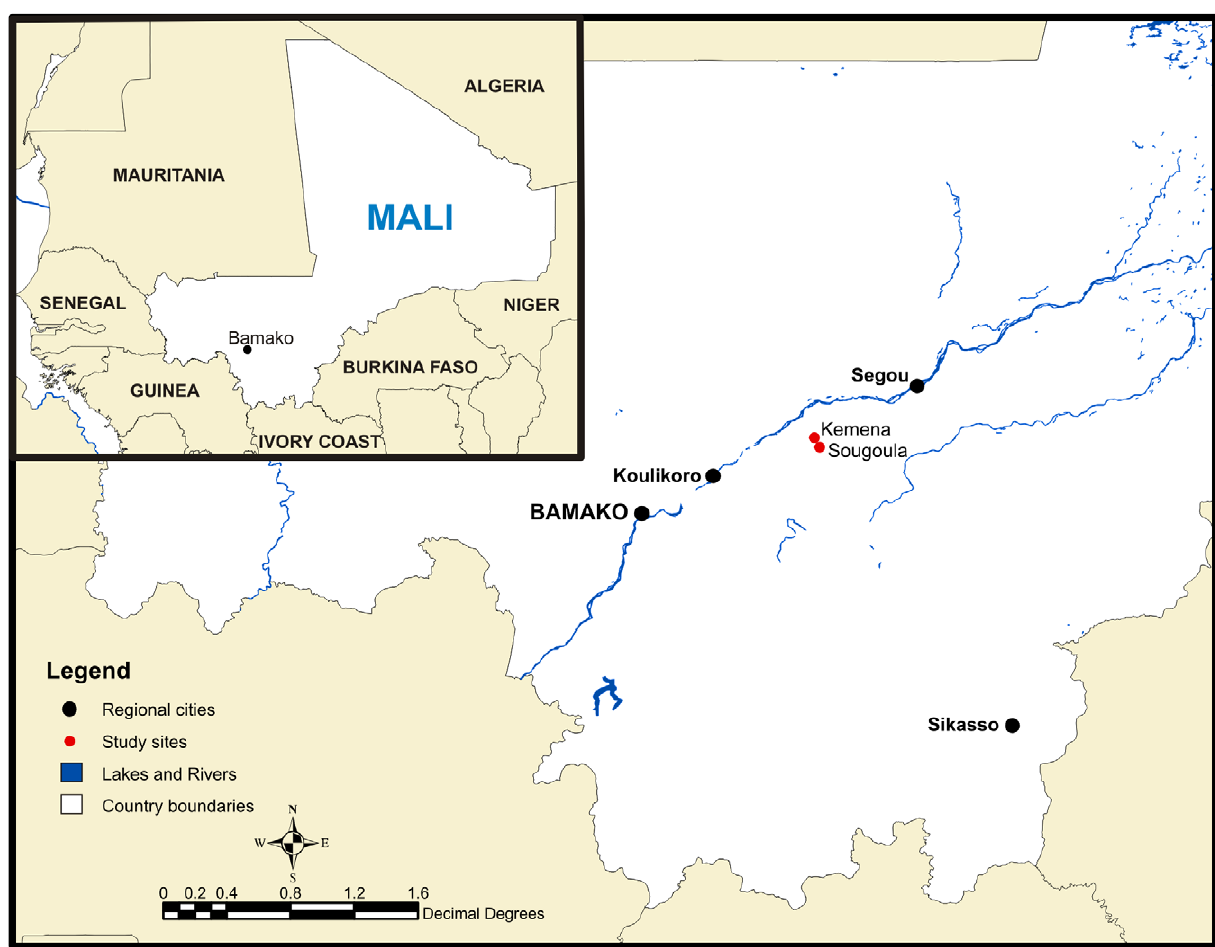
Figure 1. Map of Kemena and Sougoula, Region of Segou, Mali. The villages of Kemena and Sougoula are situated between the cities of Bamako and Segou. The insert illustrates the location of Mali in relation to other countries in West Africa.